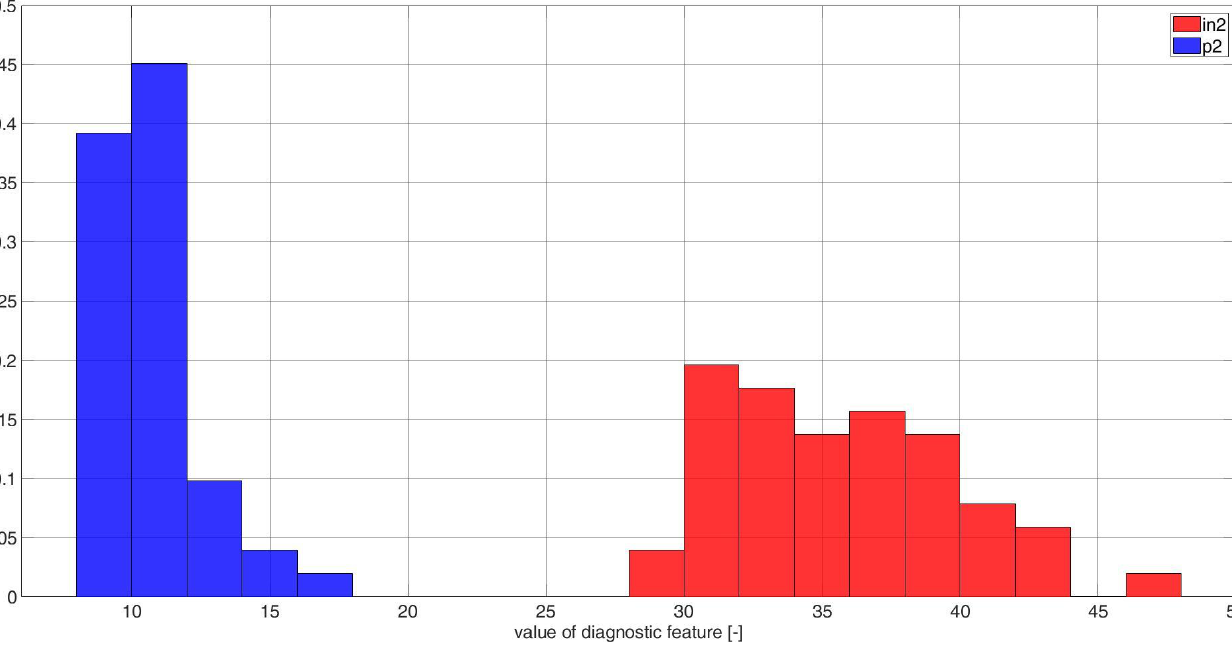
Figure A3. Histograms of diagnostic features based on the CCSM3 (correlation number is 5 — Table A1) bearings in1 and p1.